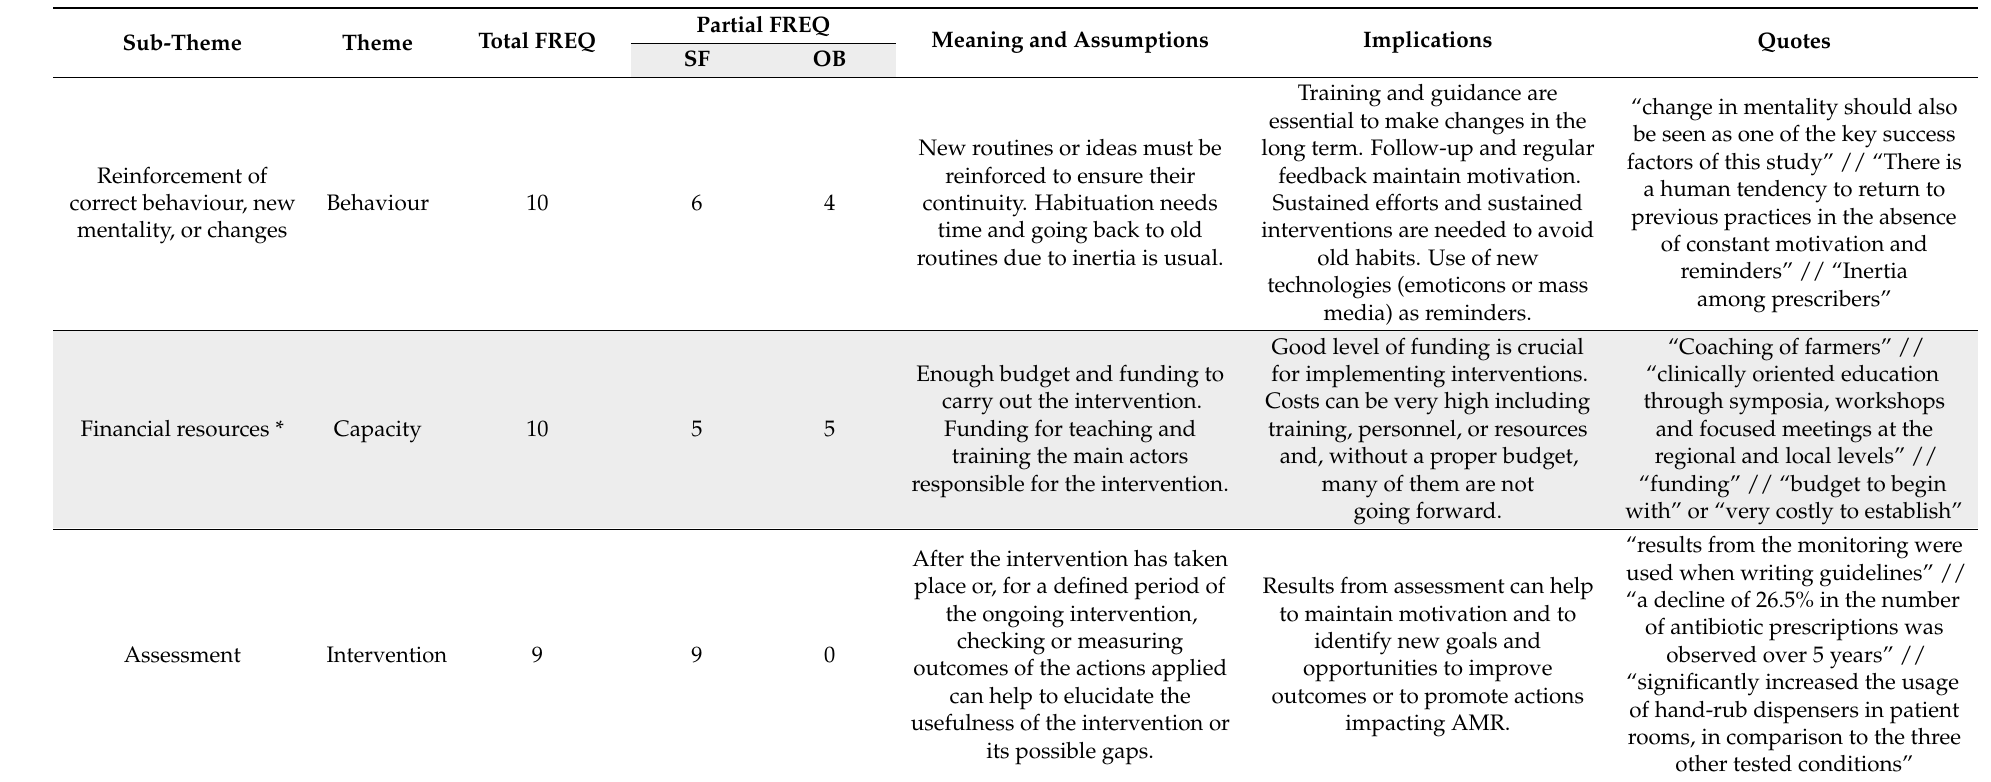
Table 2. Meaning, assumptions, implications, and supporting quotes of the 12 key sub-themes, which were reported in at least one third of the interventions, resulting from the thematic analysis. The main theme where they belong and the total and partial frequency of each are also specified. AMR = antimicrobial